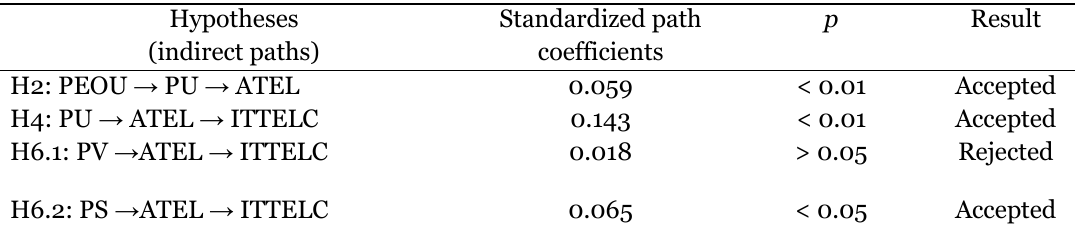
Results of Hypothesis Testing for Mediation